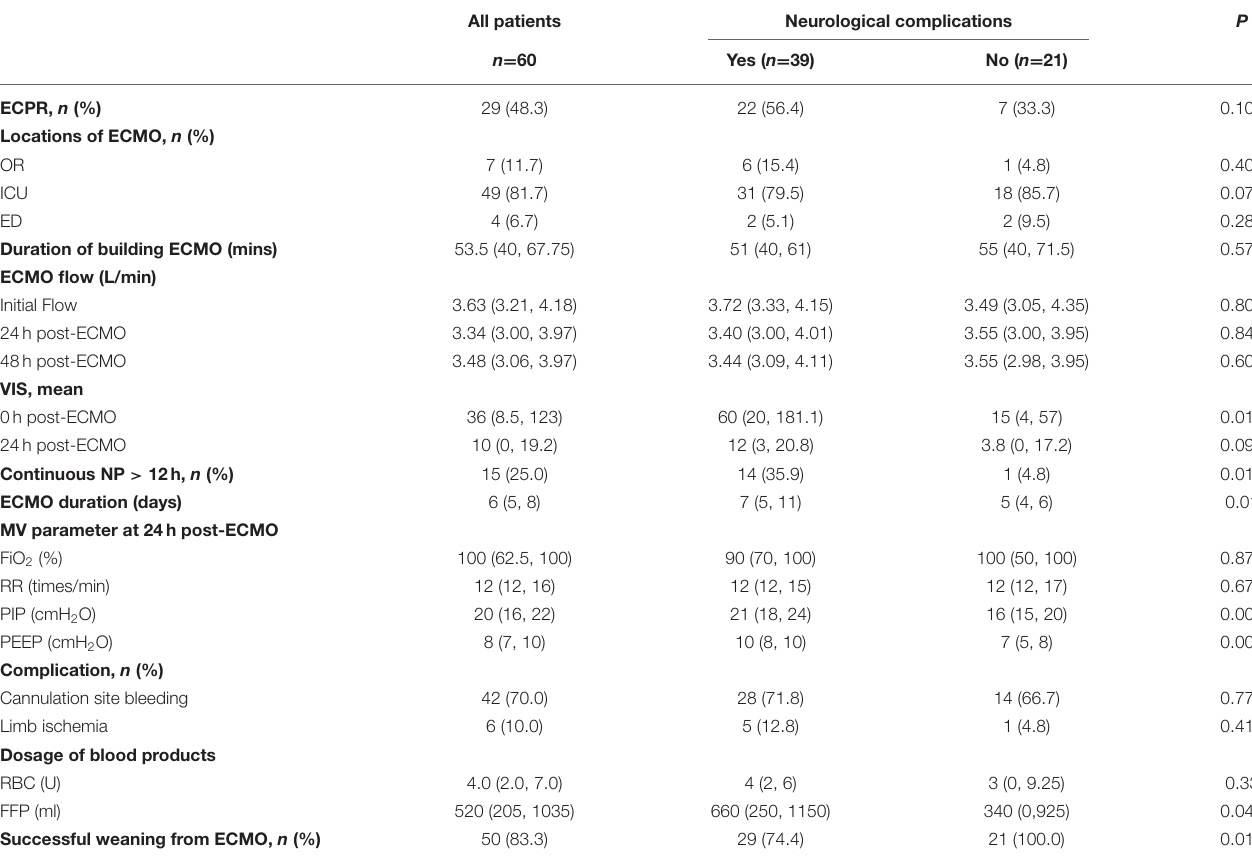
TABLE 2 | Comparison of V-A ECMO related characteristics.